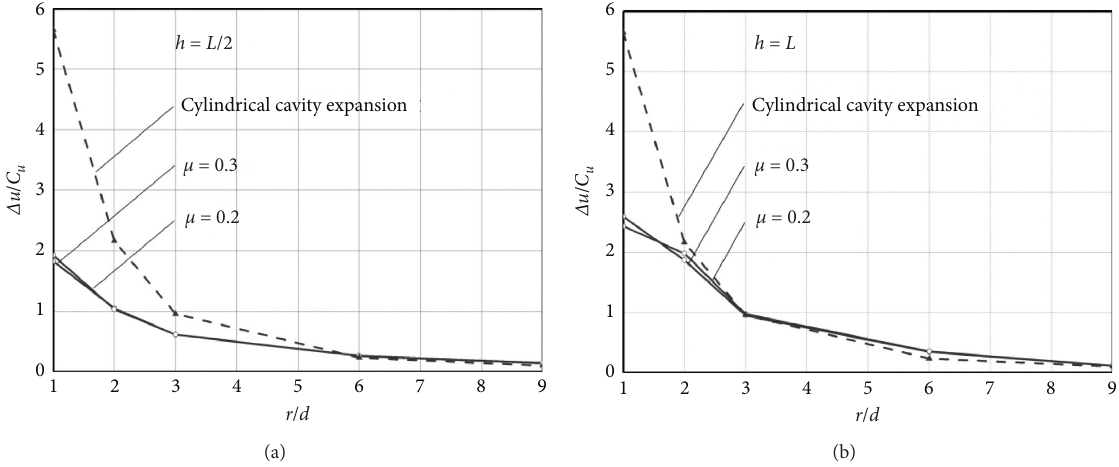
Figure 15: Excess pore water pressure ratio Δu/c